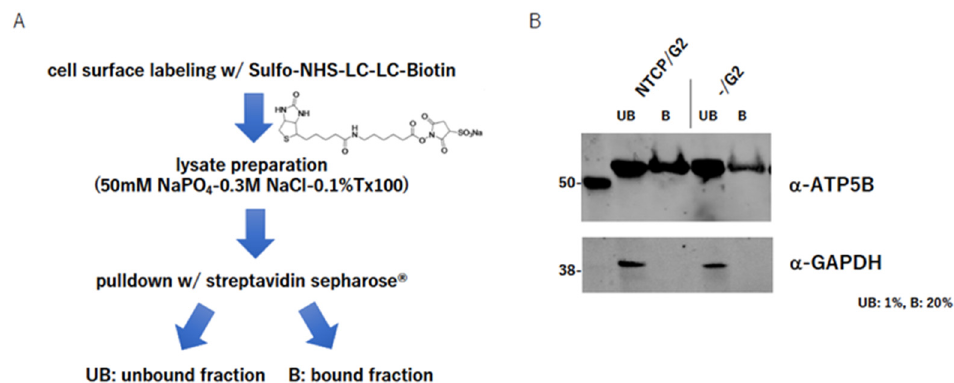
Figure 2. Detection of ATP5B on the cell surface. ( A ) The method of cell surface labeling. Sulfo-NHS-LC-LC-biotin was added to the medium of HepG2 or NTCP-expressing HepG2 cells for 30 min. The medium was withdrawn and the cells were washed with PBS (-) three times, and then lysed in a lysis buffer (50 mM NaPO 4 -0.3 M NaCl-0.1% Triton ® -X100 (Sigma-Aldrich, Darmstadt, Germany)). After excluding the cell debris, the lysate was incubated with streptavidin-Sepharose ® to pull down. The unbound fraction was obtained by centrifugation and the bound fraction was washed with the lysis buffer three times and eluted with 1 × sample buffer (62.5 mM Tris-HCl, pH 6.8, 70 mM 2-mercaptoethanol 1 mg/mL bromo-phenol blue, 10% glycerol and 2% SDS). ( B ) Detection of cell surface labeled protein. The boiled samples in the 1 × sample buffer were separated on the SDS-PAGE, blotted on a PVDF membrane and probed either with an anti-ATP5B antibody ( upper ) or an anti-GAPDH antibody ( bottom ).